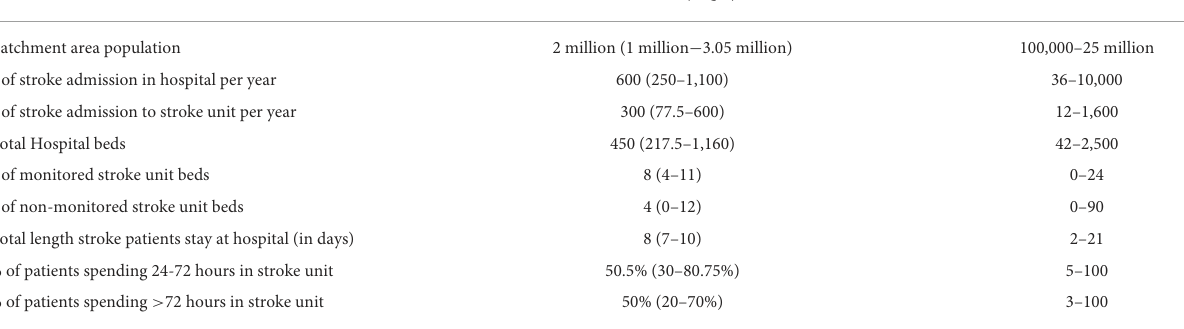
TABLE 1 General structures of the surveyed hospitals.